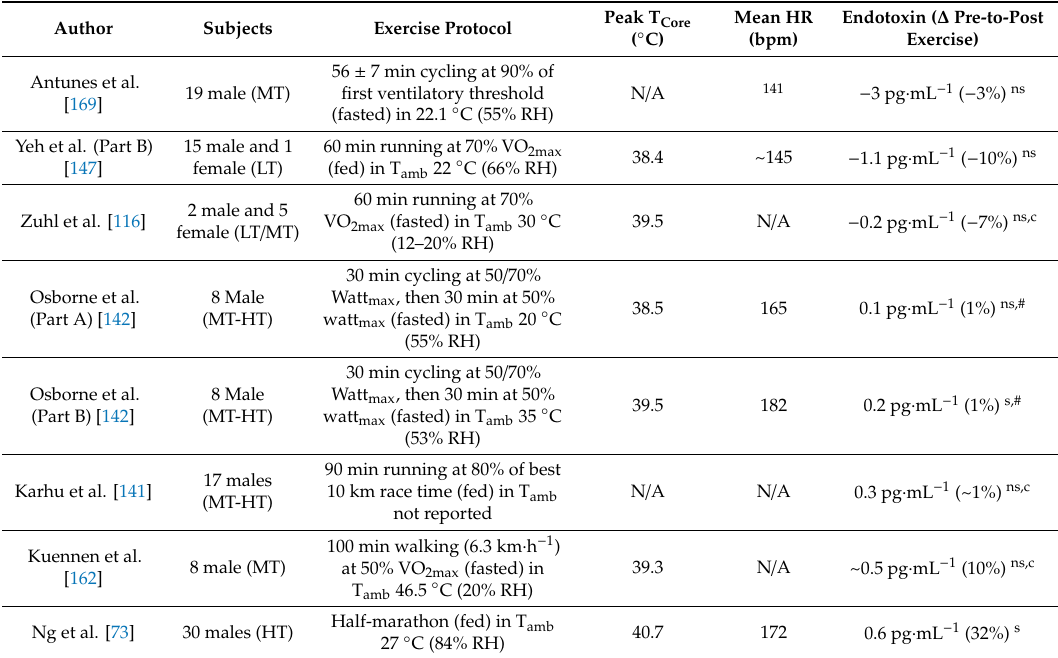
Influence of acute exercise-(heat) stress on systemic gastrointestinal microbial translocation